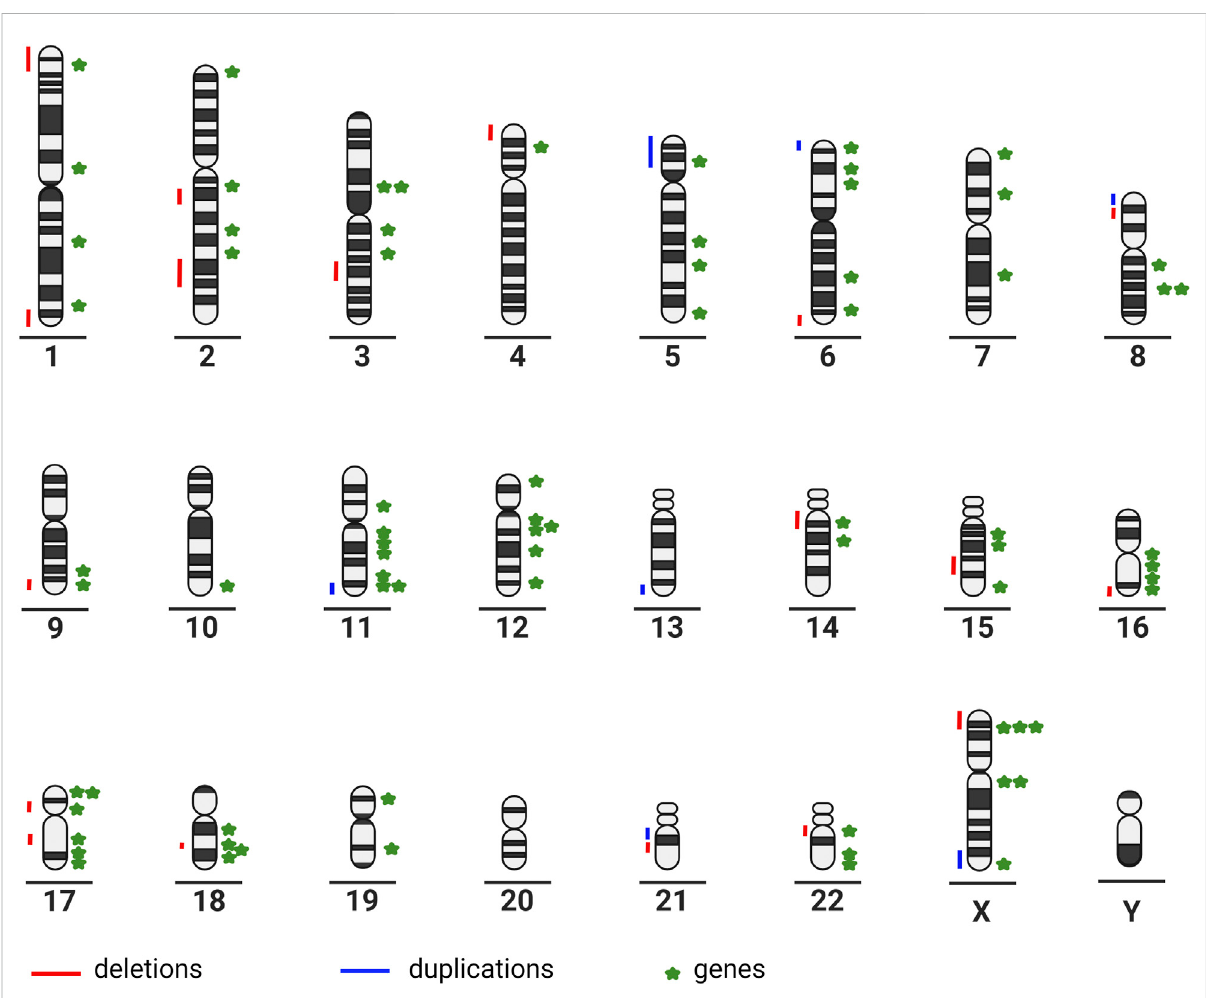
FIGURE 1 Chromosome ideograms illustrating genetic heterogeneity: partial chromosomal anomalies are represented on the left-hand side of the ideogram; genes associated with ACC are represented on the right-hand side of the ideogram (created in BioRender – publication license May- 30 – 2022); (Chromosome 1 : ARID1A, GPSM2, KIF14, FH. Chromosome 2: SOX11, NPHP1, ZEB2, LRP2. Chromosome 3 : HESX1, PDHB, ZBTB20, NPHP3. Chromosome 4 : CC2D2A. Chromosome 5 : CPLANE1, ALDH7A1, TXNDC15, NSD1. Chromosome 6 : TUBB2B, SOX4, TUBB, AHI1, ARID1B. Chromosome 7 :ACTB, GLI3, DLD. Chromosome 8: CSPP1, TMEM67, PDP1. Chromosome 9 :CDK5RAP2, INPP5E. Chromosome 10 :FGFR2. Chromosome 11 : PDHX, DPF2, TMEM216, DHCR7, DLAT, HYLS1, ROB O 3. Chromosome 12 : C12orf57, ARID2, TUBA1A, SMARCC2, CEP290, TCTN2. Chromosome 14 : FOXG1, KIAA0586. Chromosome 15 : SLC12A6, RAD51, KIF7. Chromosome 16 : CREBBP, RPGRIP1L, TMEM231, TUBB3. Chromosome 17 : TMEM107, NTN1, B9D1, SMARCE1, MKS1, ACTG1. Chromosome 18 : EPG5, DCC, PIGN, RTTN. Chromosome 19 : SMARCA4,